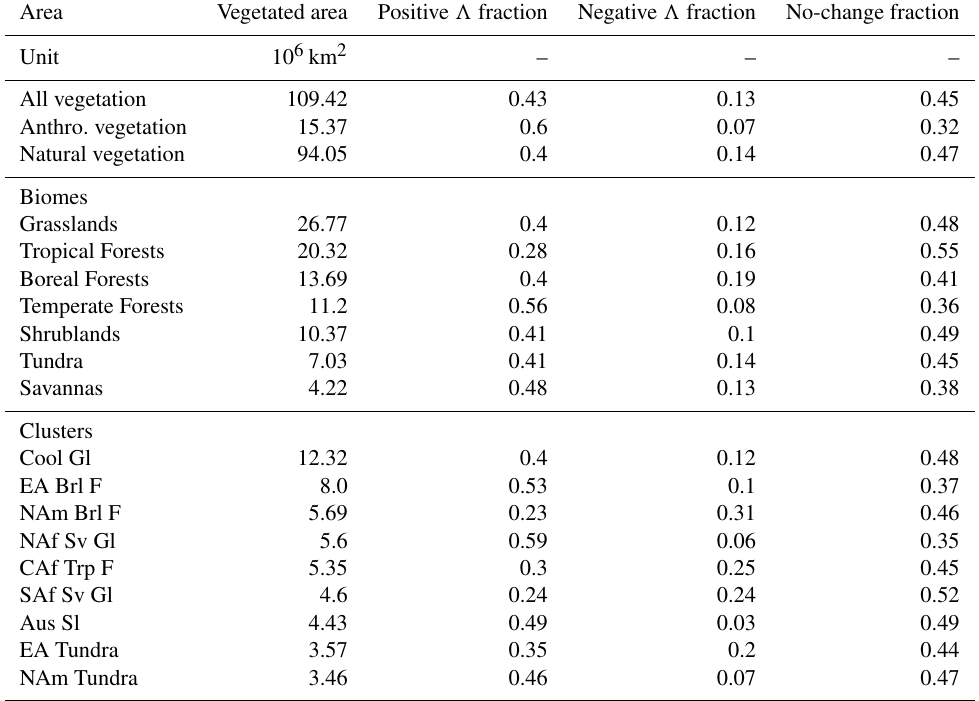
Table 1. Greening (positive (cid:51) ), browning (negative (cid:51) ) and non-changing fractions of vegetated area for different biomes and prominent clusters of change for the time period 1982–2017. Significant changes are determined by the means of the Mann–Kendall significance test ( p < 0 . 1). The abbreviations used to describe the different clusters are explained in “Materials and